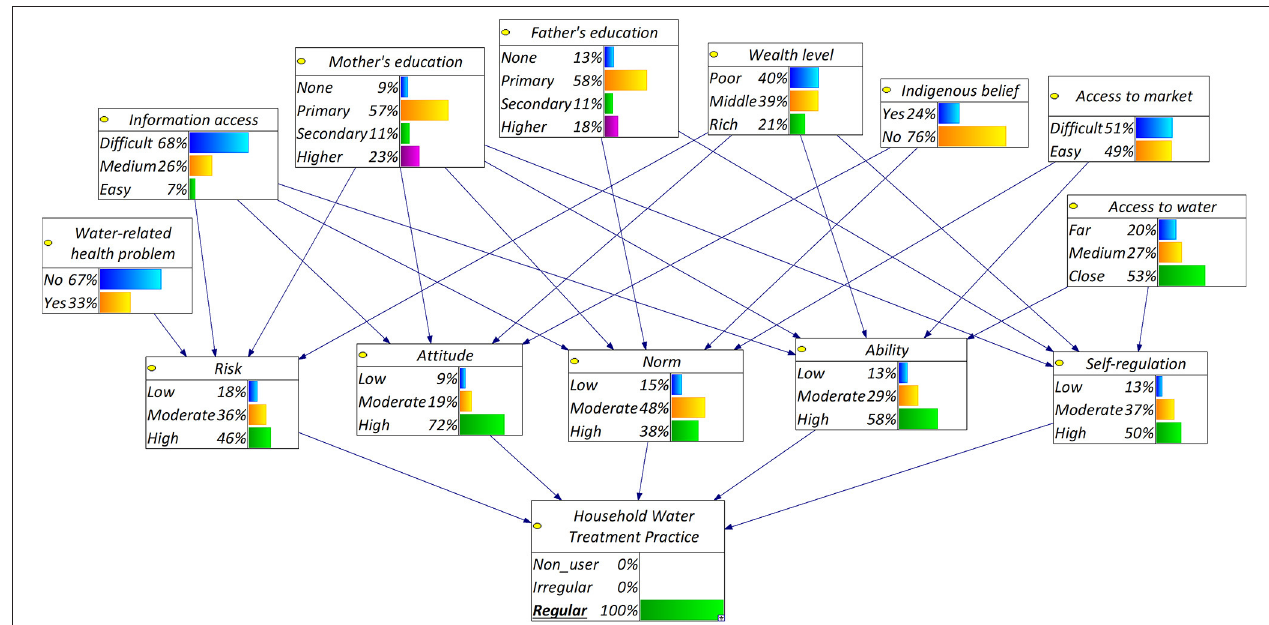
FIGURE 7 | Diagnostic inference: most probable states of all SEC and psychological factors that will lead to the probability of regularly practice HWT to